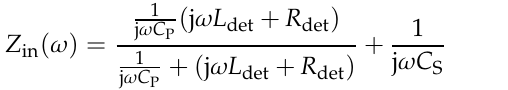
Figure 11. System topology. In this way, the inductance variation of the detection coil α is converted into the voltage variation. Despite the use of bipolar detection coils, it is difficult to completely cancel out the induced voltage in the detection coils, so a third order high ‐ pass filter is used to filter out the noise near the power transfer frequency. A diode is utilized to convert the AC output voltage into the direct current (DC) output voltage, U out , so that a low ‐ cost voltage sensor can be used to measure the DC output voltage. The voltage gain of the overall system is defined as: